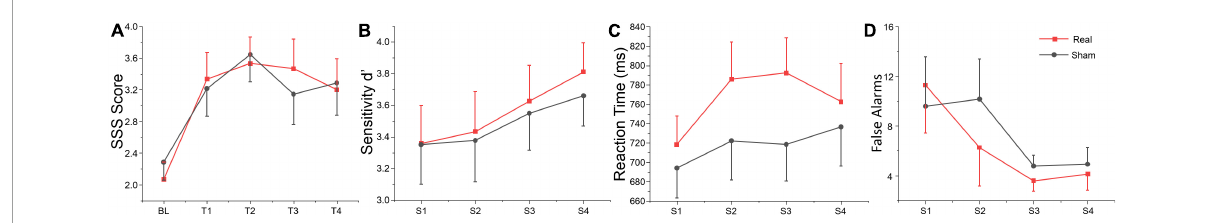
FIGURE2 Behavioral data. S1, S2, S3, and S4 indicate session 1 to session 4, respectively. (A) Self-reported vigilance for the SSS at each time point. (B) Sensitivity d’, (C) reaction time, and (D) false alarms during the vigilance task across each session. The error bars indicate the standard error of the mean (SEM), the same below.